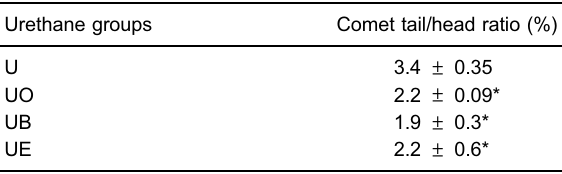
Table 1. Distribution of comet tail/head ratio in urethane-injected and urethane-supplemented groups. Urethane